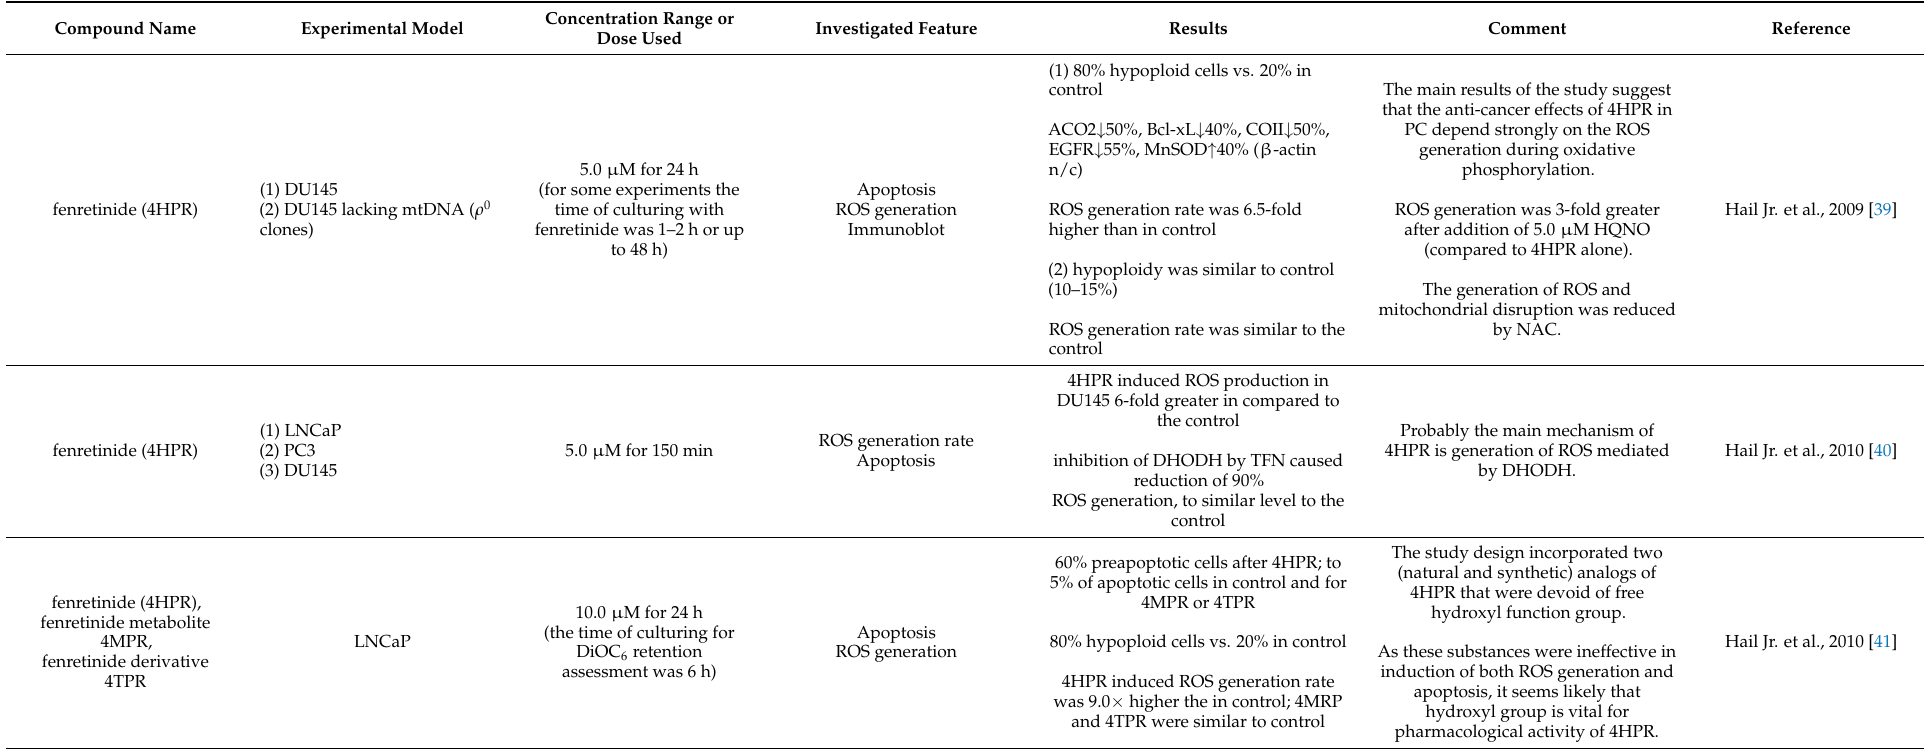
Table 1. Overview of results of laboratory studies investigating the impact of synthetic retinoids on prostate cancer (cell lines, PC tissue or mice